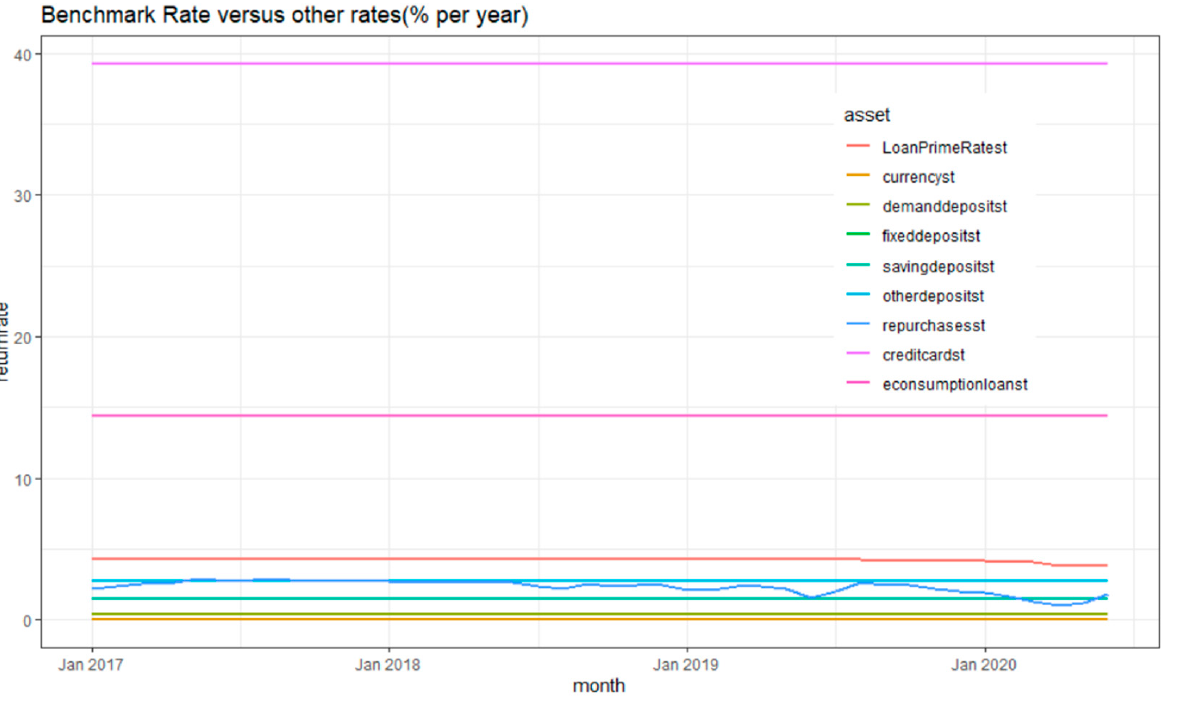
Figure 1. Benchmark rate and other rates (2017–2020). Based on simple sum monetary aggregation and the published Divisia Monetary